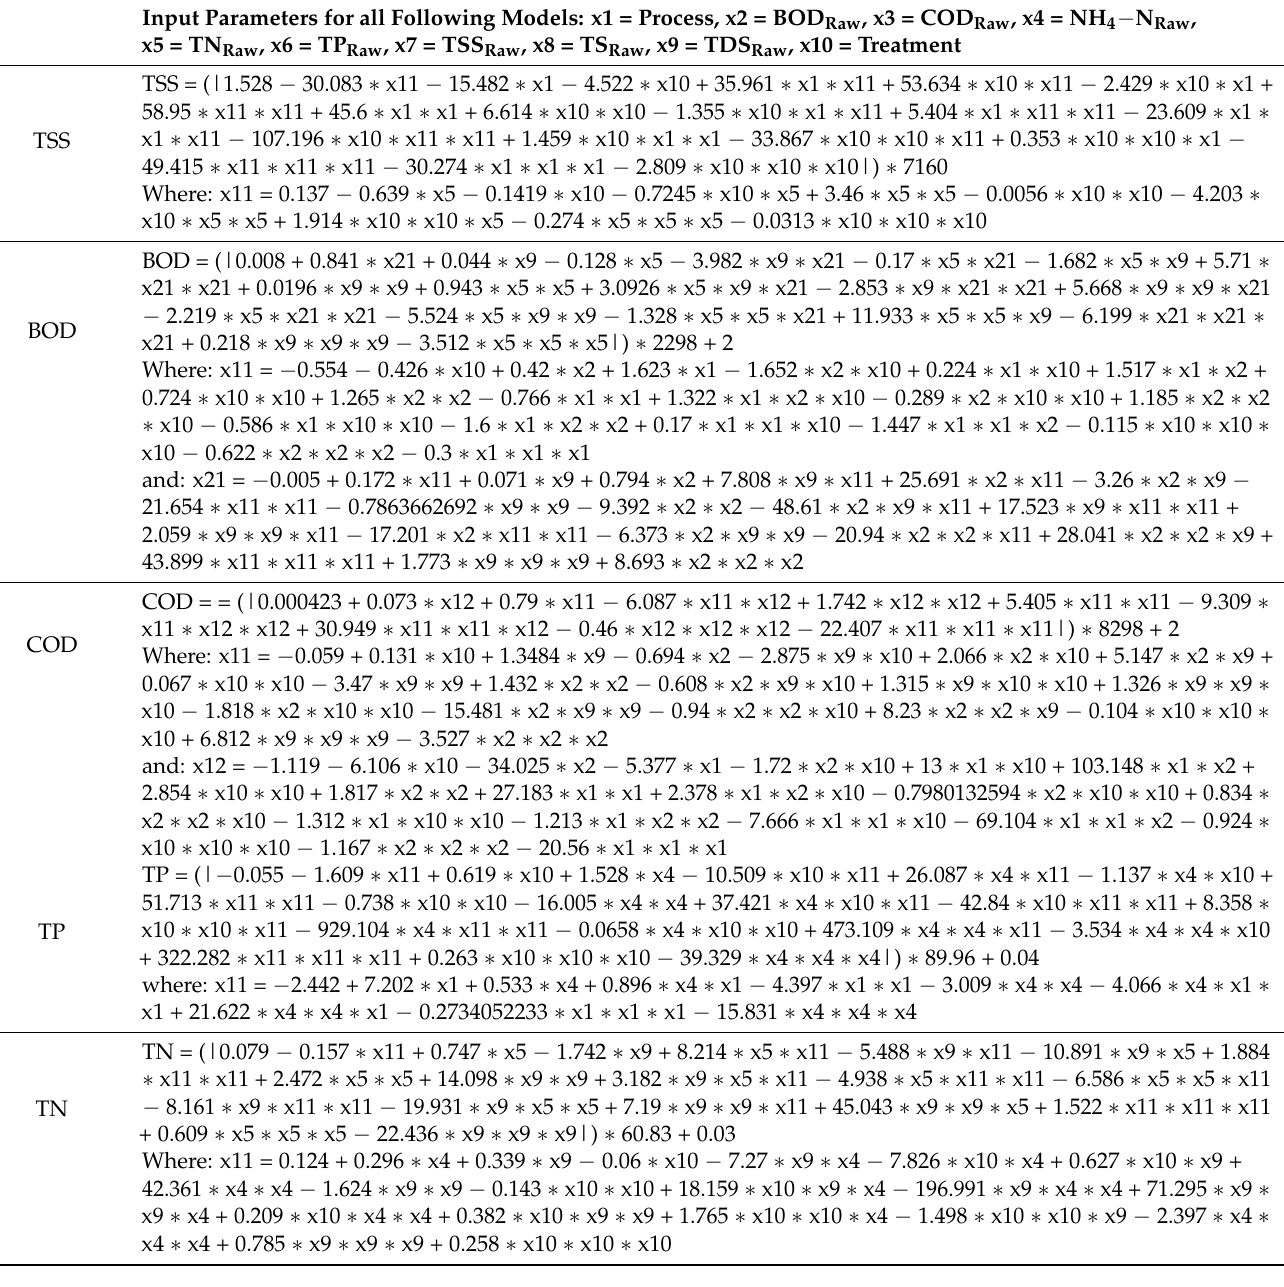
Table 6. The developed GSGMDH based equation for